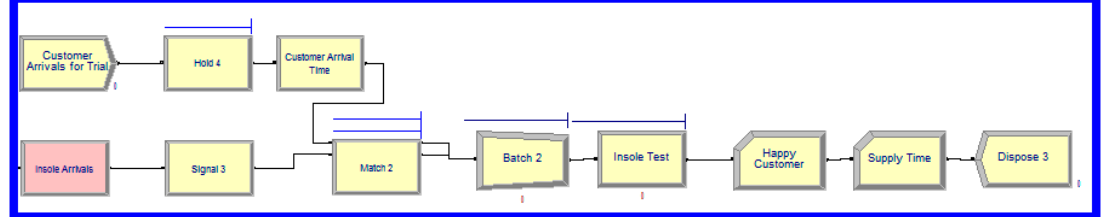
Figure 15. Arrival of customers and testing of insole in the office of orthopedist.